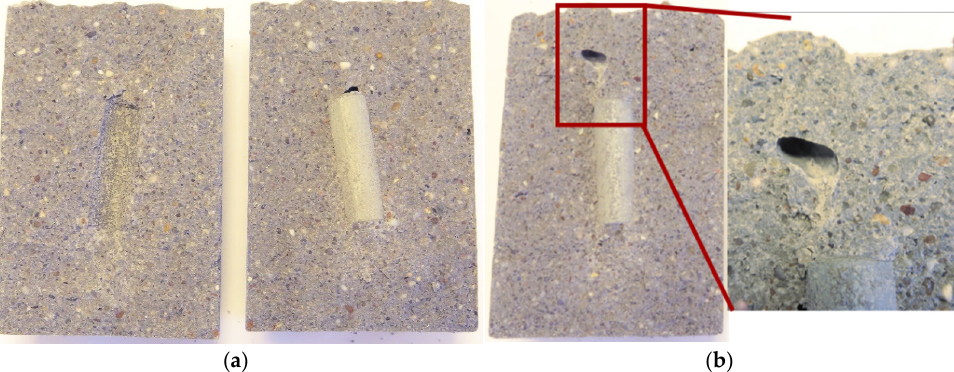
Figure 5. ( a ) Small voids formed at the top end of some of the embedded Zn samples and ( b ) Some voids penetrated deeper into the concrete without puncturing the outer concrete cylinder